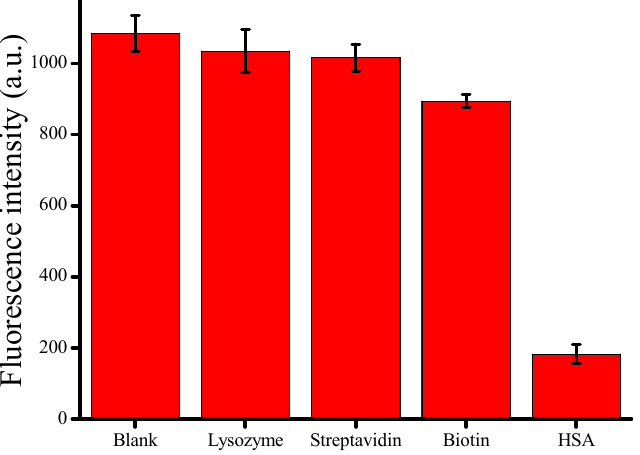
Figure 4. Fluorescence intensity of CuNPs in the presence of lysozyme, streptavidin, biotin and HSA under optimized concentrations. Error bars were estimated from three replicate measurements.